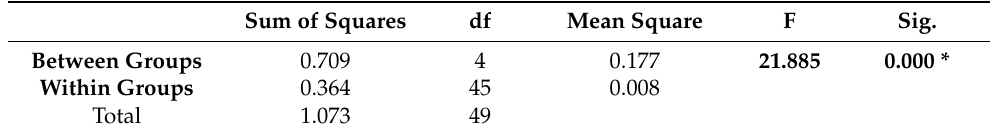
Table 11. The comparison with ANOVA Test (Antioxidant Inhibition DPPH). Sum of Squares df Mean Square F Sig. Between Groups 0.709 4 0.177 21.885 0.000 * Within Groups 0.364 45 0.008 Total 1.073 49